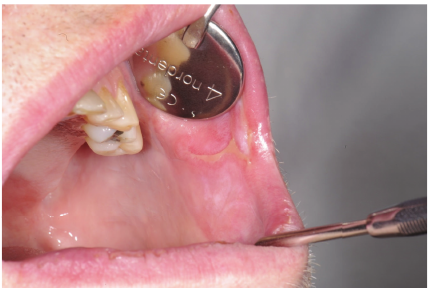
Figure 1: Clinical appearance of buccal ulceration.